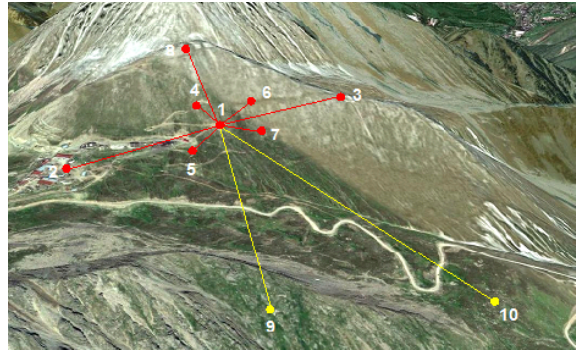
Figure 1. Aerial view of the Horizon-10T detector system.